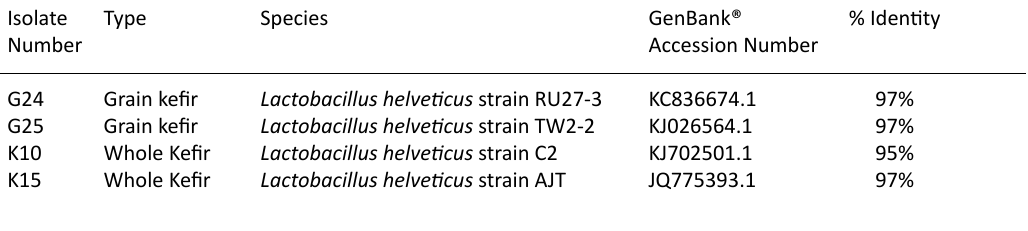
Table 4. Identification of LAB isolate based on homology (%) of DNA fragment sequence region 16S rRNA.